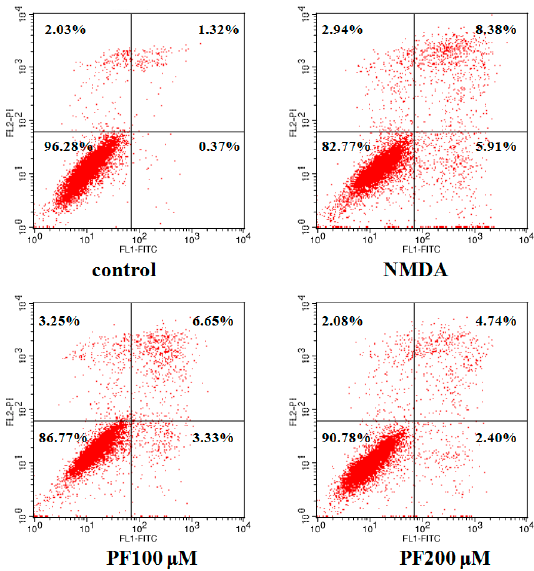
Figure 4. Effect of PF in NMDA-induced neurons apoptosis by annexin V/propidium iodide (PI) staining (flow cytometry analysis). NMDA stimulation increased cell apoptosis in neurons. PF